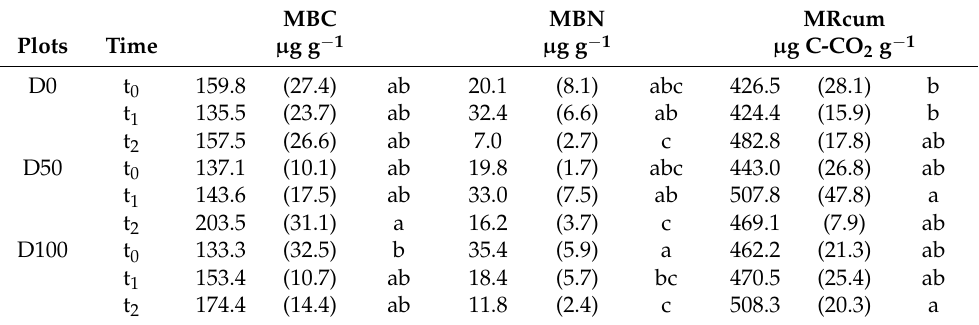
Table 6. Soil microbial biomass C (MCB), microbial N (MBN) and cumulative microbial respiration (MRcum) under different fertilization treatments (D0, D50, D100) and at different sampling times (t 0 , t 1 , t 2 ) (means followed by standard error in brackets). Different letters indicate significant differences between soil samples at p ≤ 0.05 (Fisher LSD test). MBC MBN MRcum